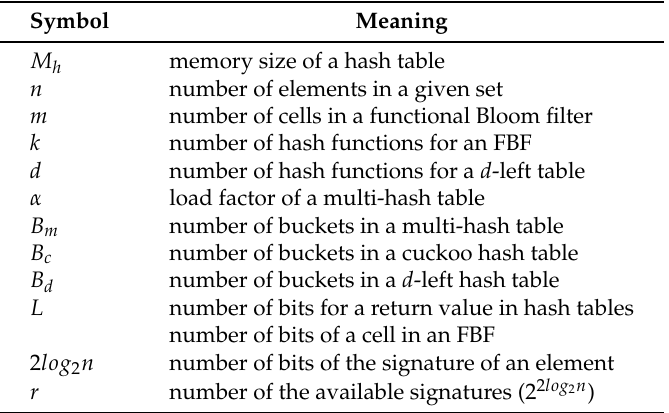
Table 1. Notation and